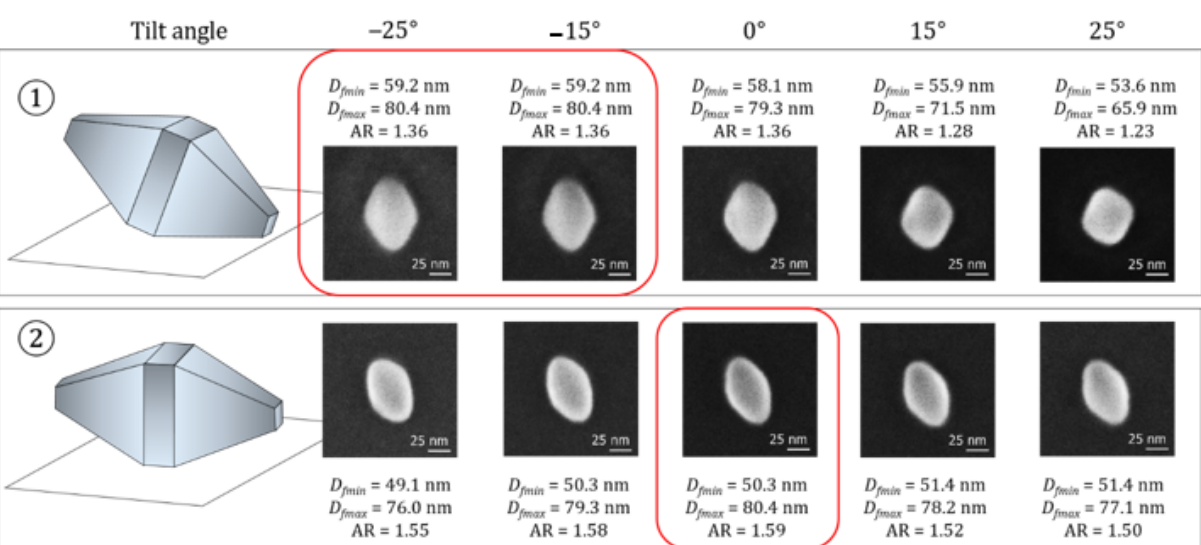
Figure 9. Changes in the 3 kV SEM images of TiO 2 NPs performed after tilting the stage of the instrument between –25° and +25° in five steps. An example for each orientation ① and ② is given. Monitoring the angle, in which the D fmax value reaches a maximum, allows us to identify the two different geometric orientations of the imaged TiO 2 NP deposited on the